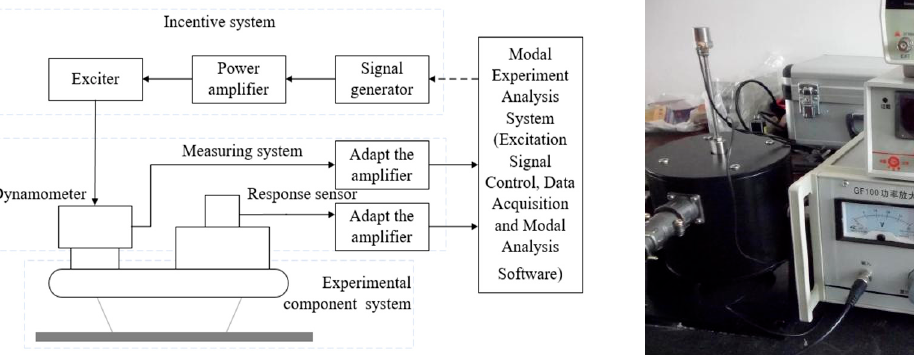
Figure 3. Flowchart of the mode experiment system.